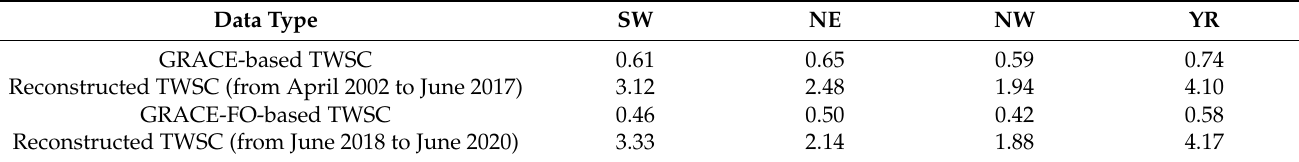
Table A1. RMS of GRACE/GRACE-FO-based TWSC and reconstructed TWSC data (unit: